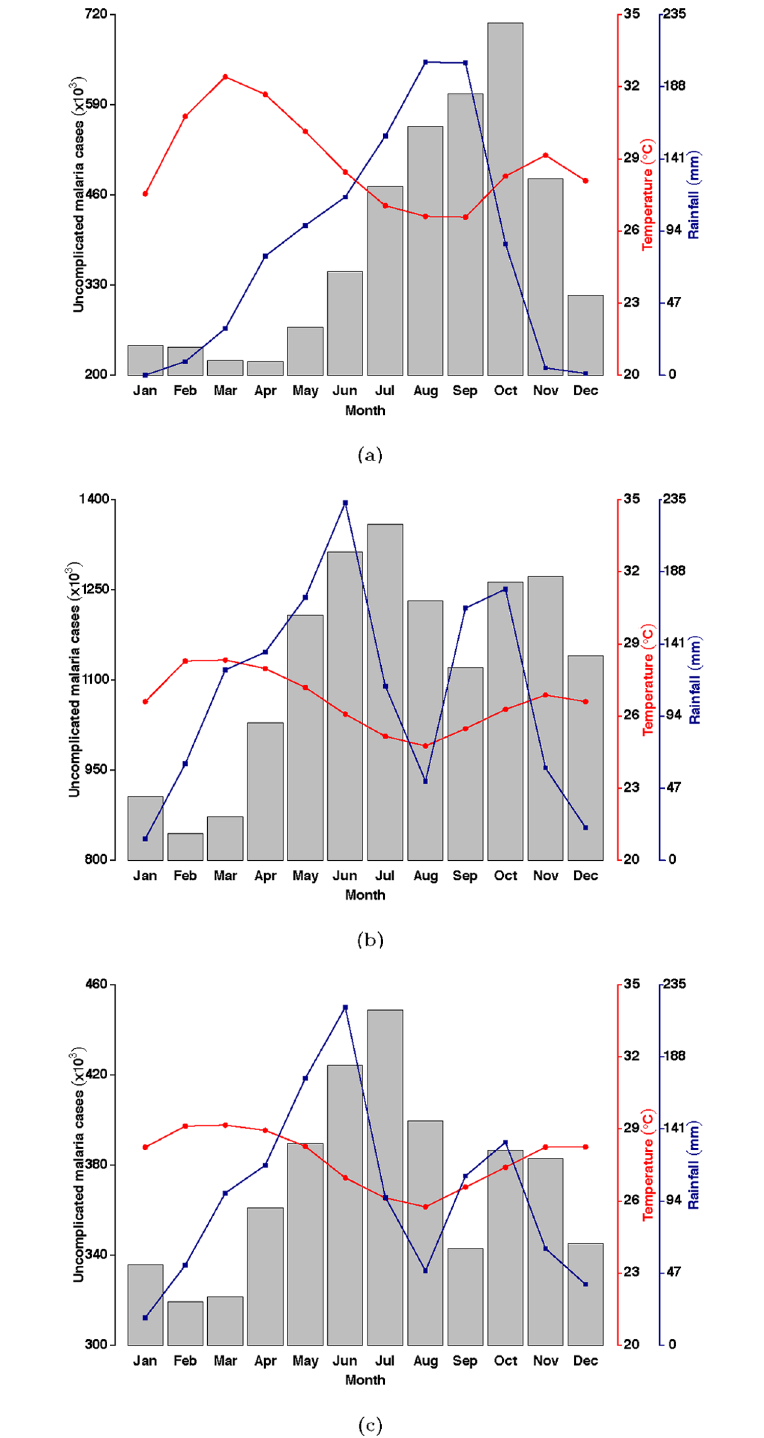
Fig 3. Patterns of aggregated cases of uncomplicated malaria for the (a) Guinea savannah, (b) Transitional forest, (c) Coastal savannah by month for 2008 to 2016.